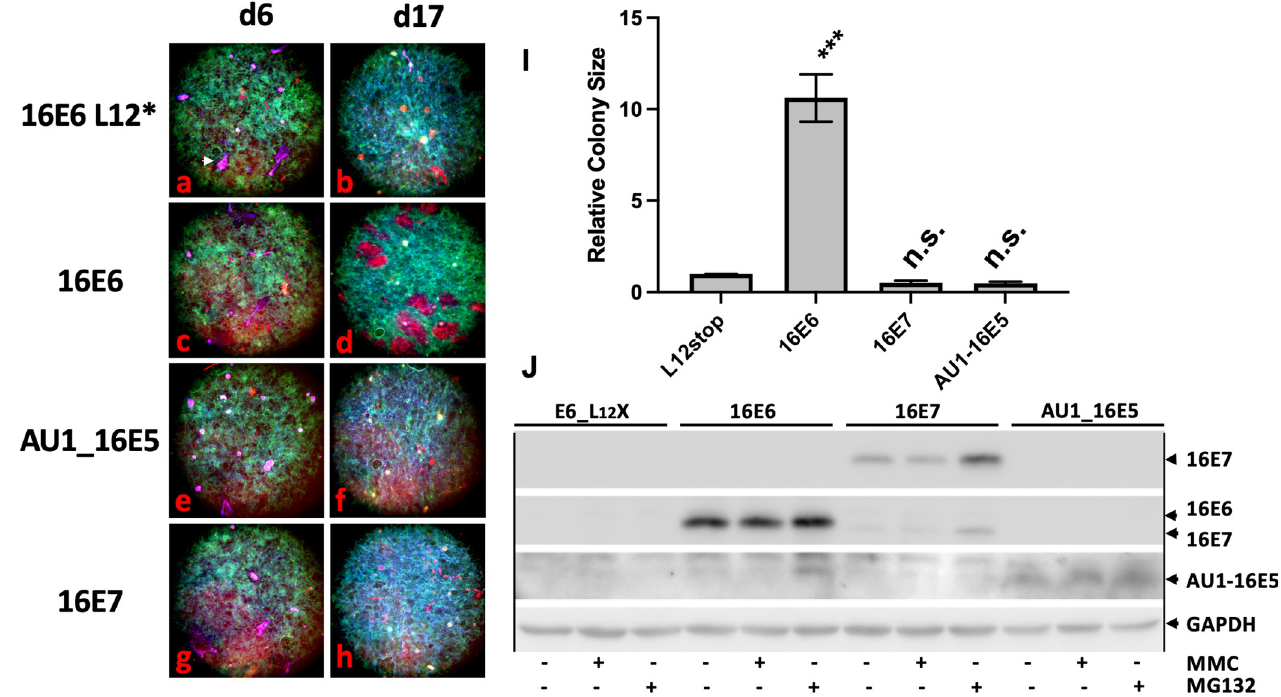
Fig 3. 16E6 induces cell colony competition while 16E5 and 16E7 do not. The individual HPV16 oncoproteins were transduced into Fusion-Red tagged NIKS cells and set into competition against EGFP-tagged NIKS cells as described in Fig 1; E5 (Fig 2E and 2F), E6 (Fig 2C and 2D), and E7 (Fig 3G and 3H). 16E6 with a stop codon at amino acid 12 (L12X, Fig 3A and 3B) was the negative vector control. Magenta colonies (indicated with a white arrowhead in Fig 3A) are patches of feeder cells and are not included in the colony analysis. Plates were stained at day 6 when confluent and day 17 when super-confluent. Pictures were taken with a 4X objective and relative colony sizes ascertained at day 17 and shown in arbitrary units (Fig 3I) from 4 separate experiments. Day 6 colony sizes were not statistically different between the samples and are not shown. Error bars represent standard error of the mean. ���� is P < 0.0001; n.s. is not significant. The pictures shown are representative from one of 4 separate assays. Expression of the papillomavirus oncoproteins in the same cell lines used in this experiment is shown in Fig 3J where the blot was sequentially probed with monoclonal antibodies to E7, E6, and the AU1 epitope on E5 and finally